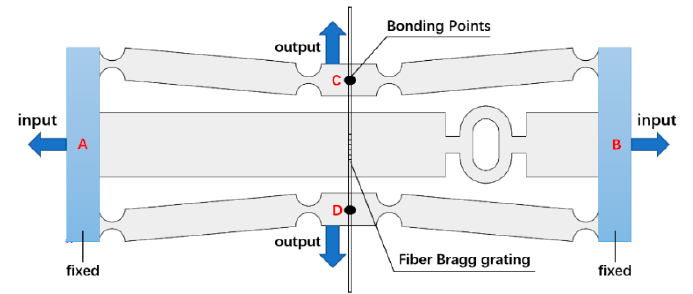
Figure 2. Schematic diagram of the sensor.